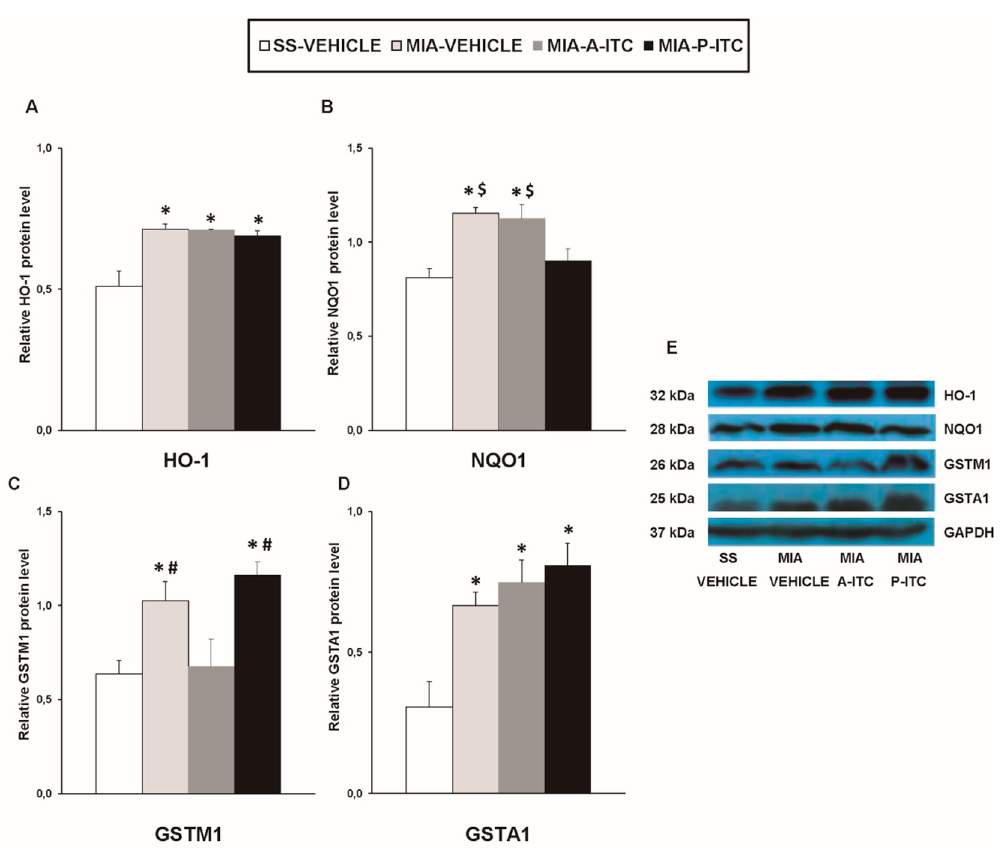
Figure 8. A-ITC and P-ITC treatments inhibit the overexpression of phosphatidylinositol 3-kinase (PI3K) and protein kinase B (p-Akt) in the hippocampus of mice with osteoarthritis pain. The relative protein levels of ( A ) PI3K and ( B ) p-Akt/Akt in the hippocampus of MIA-injected mice treated with A-ITC, P-ITC, or vehicle are presented. The SS-injected mice treated with vehicle were used as controls. ( C ) Representative blots for PI3K (140 kDa), glyceraldehyde-3-phosphate dehydrogenase (GAPDH) (37 kDa), p-Akt (60 kDa), and Akt (60 kDa). PI3K is expressed relative to GAPDH levels and p-Akt relative to total Akt. In all panels, * denotes significant differences vs. SS-injected mice treated with vehicle, # vs. MIA-injected mice treated with A-ITC and $ vs. MIA-injected mice treated with P-ITC ( p < 0.05; one-way ANOVA and Student–Newman–Keuls test). Results are presented as the mean ± SEM; n = 4 samples per experimental group.